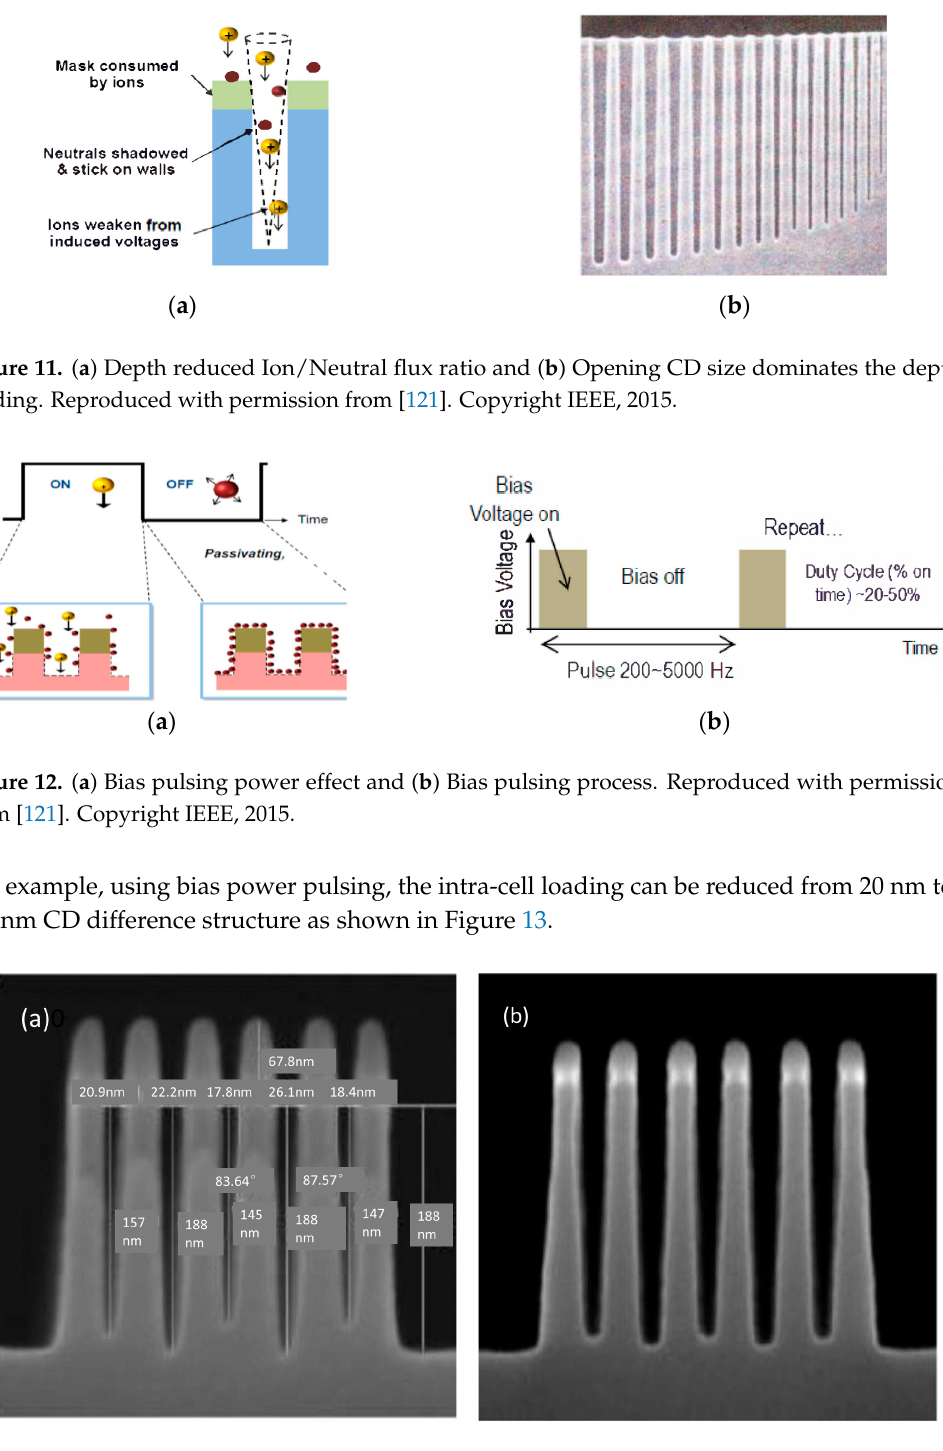
Figure 13. Bias pulsing improve intra-cell depth loading ( a ) loading without pulsing and ( b ) loading with pulsing. Reproduced with permission from [121]. Copyright IEEE, 2015.